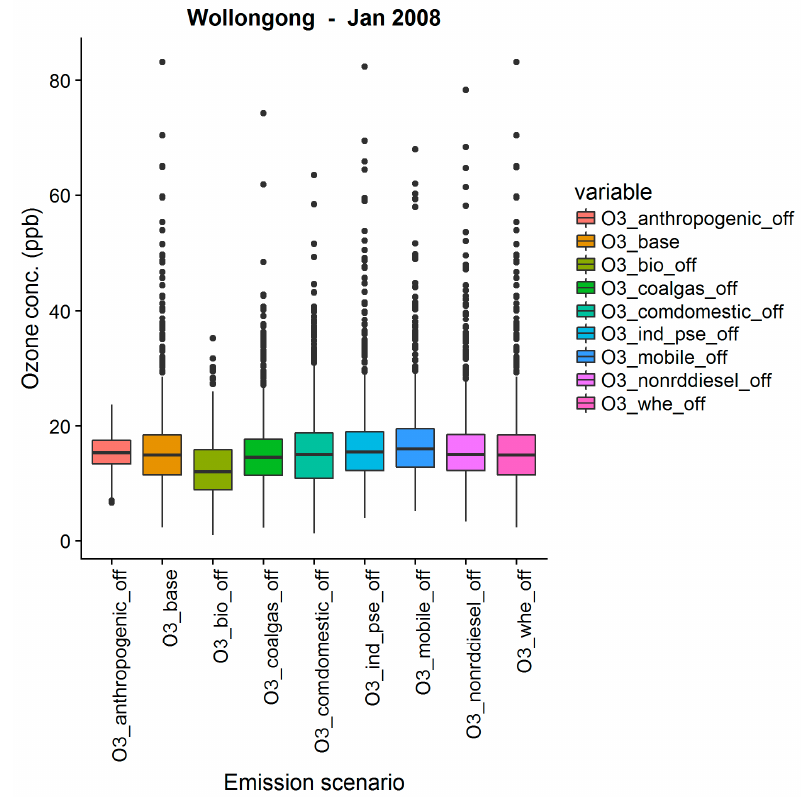
Figure A8. Box plot for 1-h ozone concentration (ppb) in January 2008 under different emission scenarios at Wollongong.